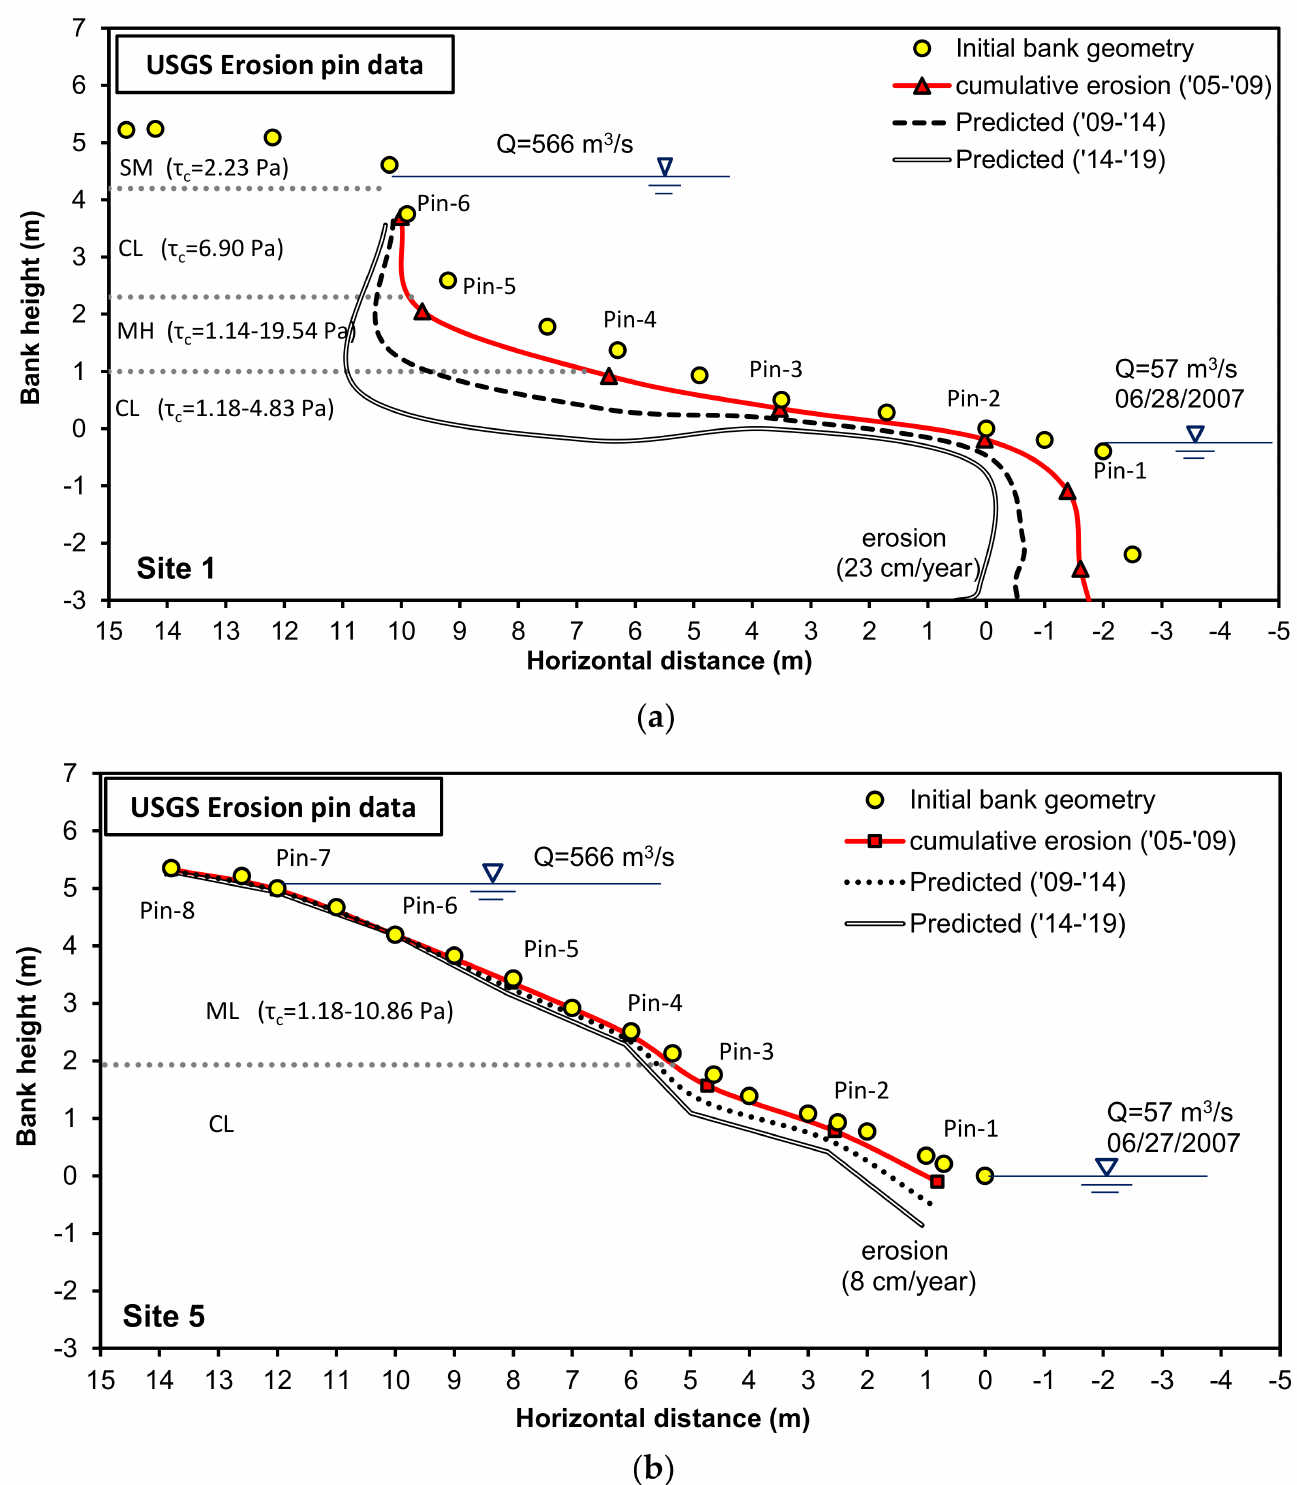
Figure 8. Cumulative and predicted erosion and bank profile: ( a ) Site 1, and ( b ) Site